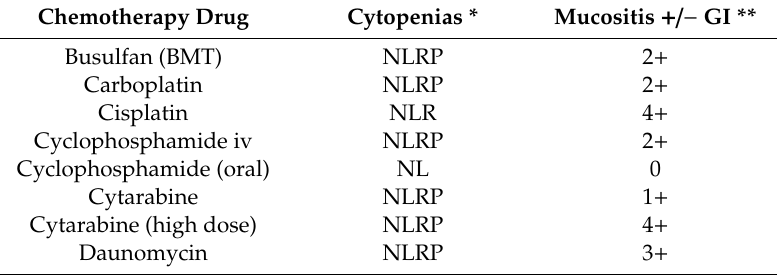
Figure 1. Physical damage and amino acid malnutrition can both contribute to slow healing and worse mucosal injury from cancer chemotherapy and / or radiation. Dietary glutamine may ameliorate some of these side e ff ects of cancer therapy. Table 1. Chemotherapy drugs and radiation-associatedˆ side e ff